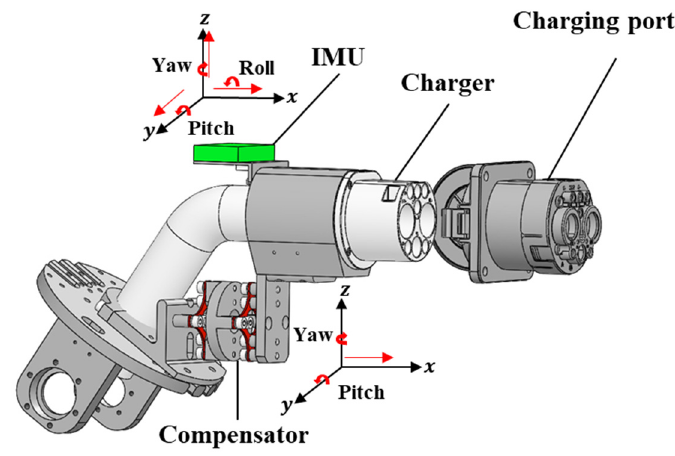
Figure 2. Vibration signal collection during insertion process. It is worth noting that the collected vibration signals also contain the vibration